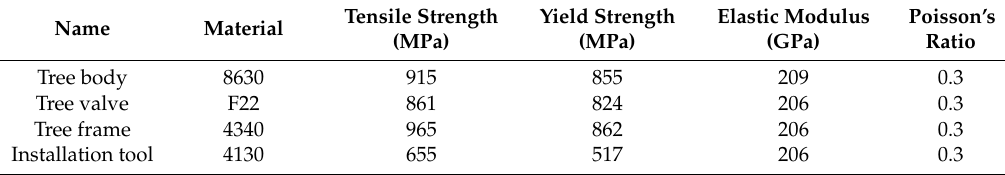
Table 5. The subsea tree and installation tool material